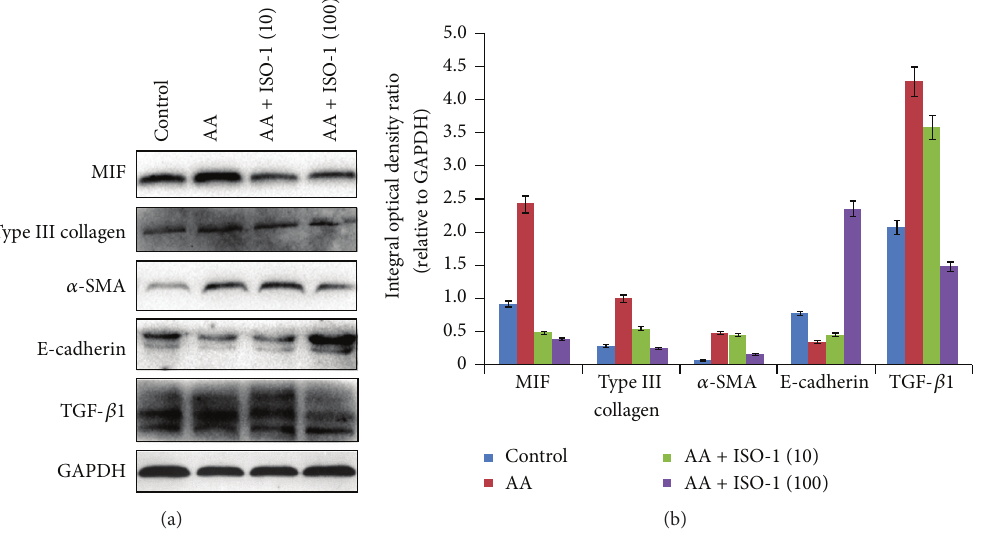
Figure 6: Inhibition of MIF abolished AA-induced EMT induction and matrix deposition in TECs. Western blot assay showed that AA increased the expression of MIF, type III collagen, 𝛼 -SMA, and TGF- 𝛽 1 and decreased the expression of E-cadherin. However, these changes including EMT induction and matrix deposition were inhibited by ISO-1